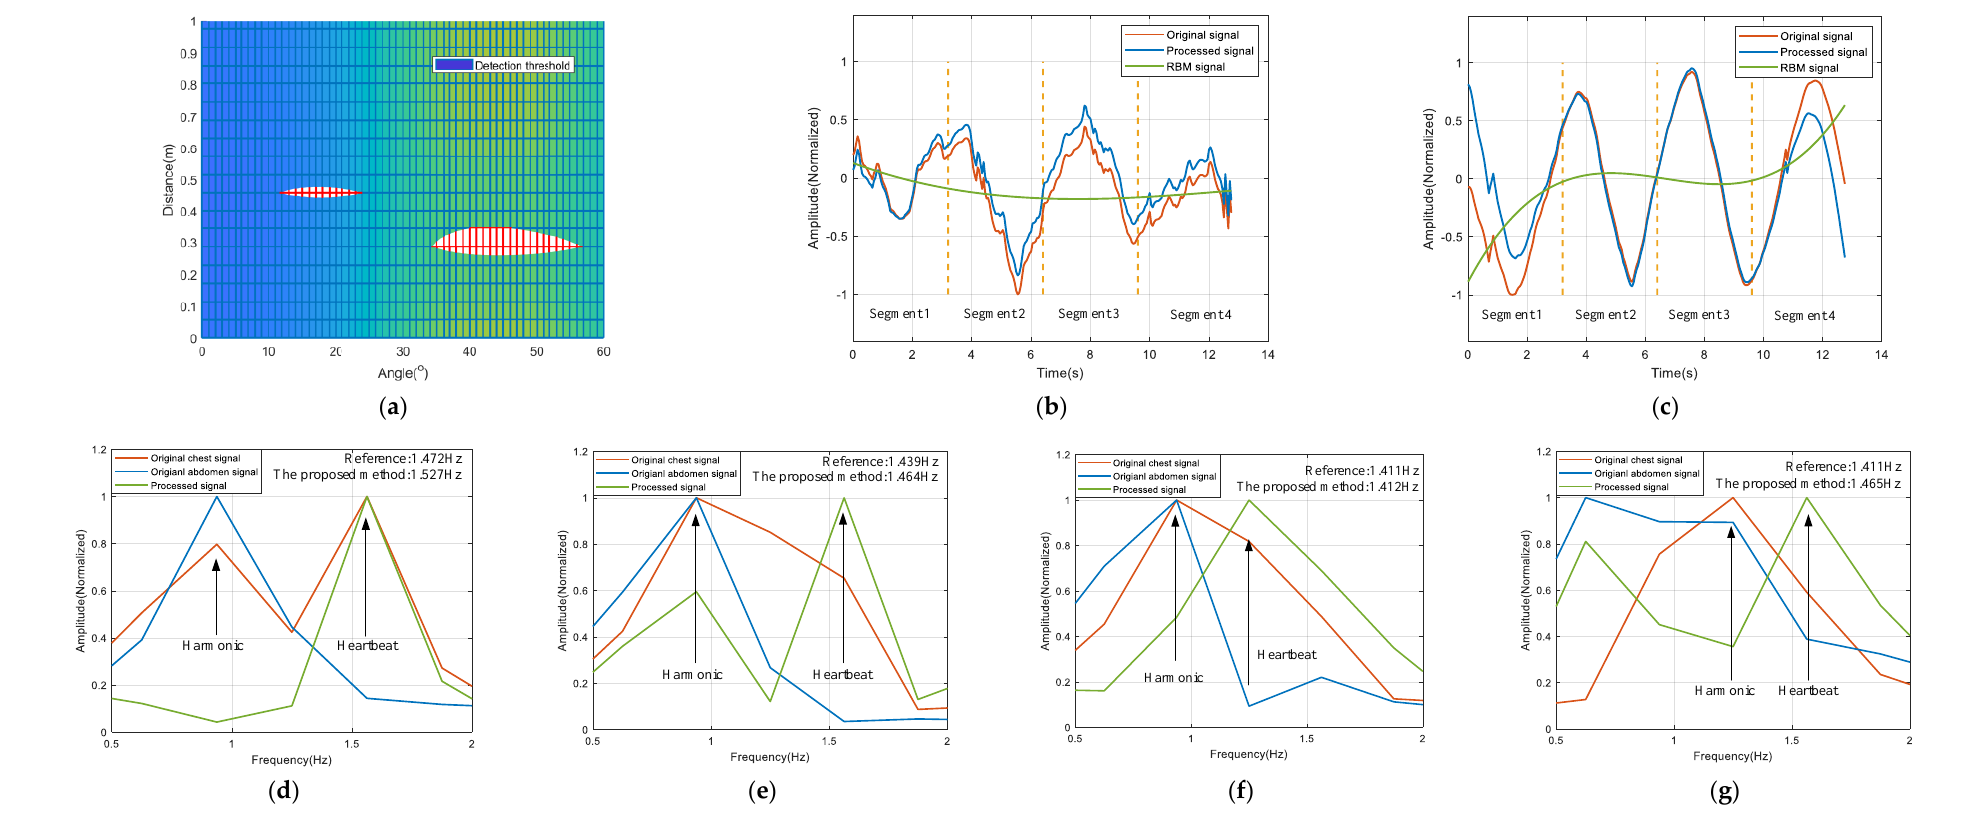
Figure 6. Experimental results: ( a ) localization results of the chest and abdomen; ( b ) the motion signal of the chest after removing the RBM signal; ( c ) the motion signal of the abdomen after removing the RBM signal; ( d ) the result of the segment 1 elimination of respiratory harmonics; ( e ) the result of the segment 2 elimination of respiratory harmonics; ( f ) the result of the segment 3 elimination of respiratory harmonics; ( g ) the result of the segment 4 elimination of respiratory harmonics.